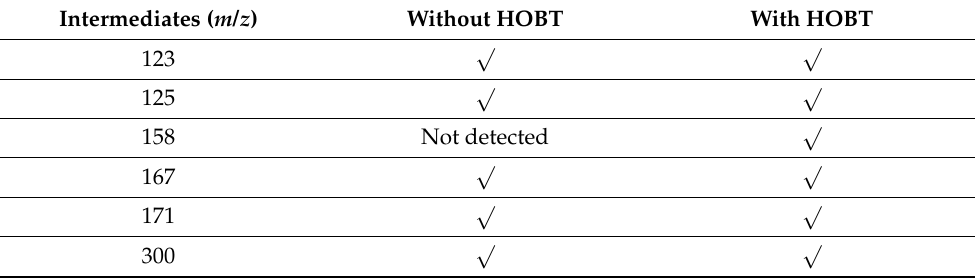
Figure 7. The structures of proposed MBT intermediates generated after Svi DyP-mediated treatment and potential pathways for the formation of the intermediates. Table 4. Mass to charge ratios ( m / z ) of intermediates generated during Svi DyP-mediated treatment of MBT with and without redox mediator, HOBT.